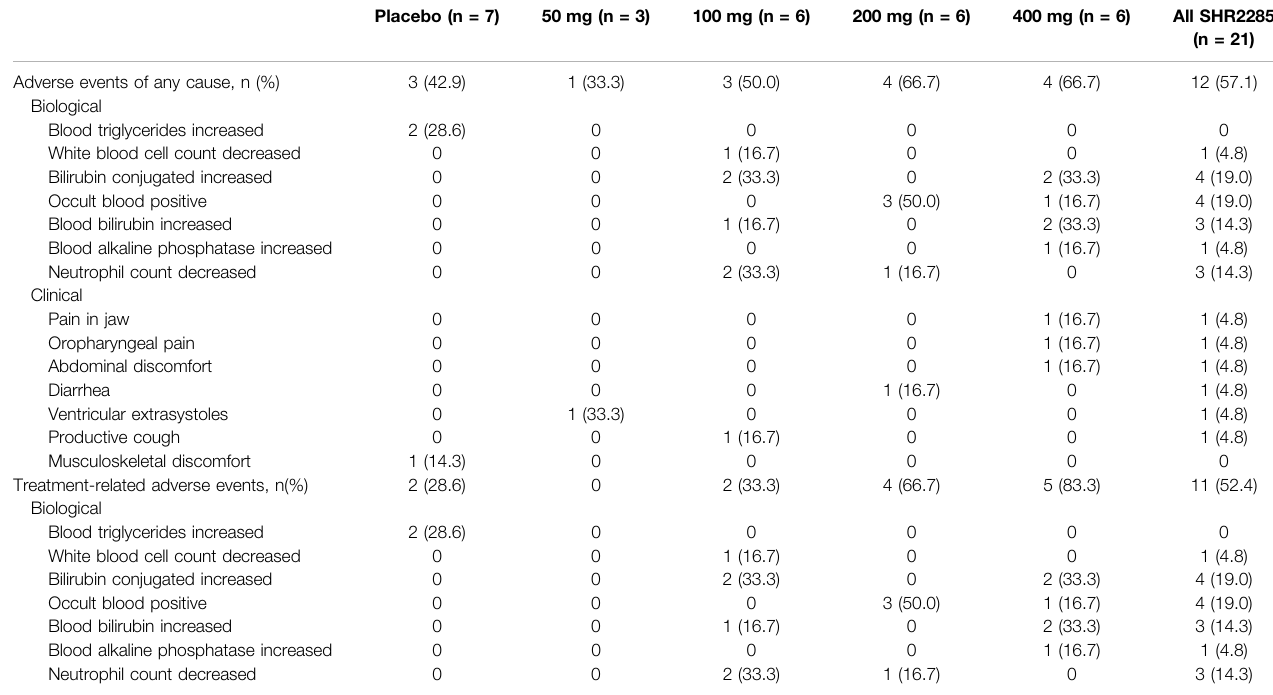
TABLE 2 | Adverse events.